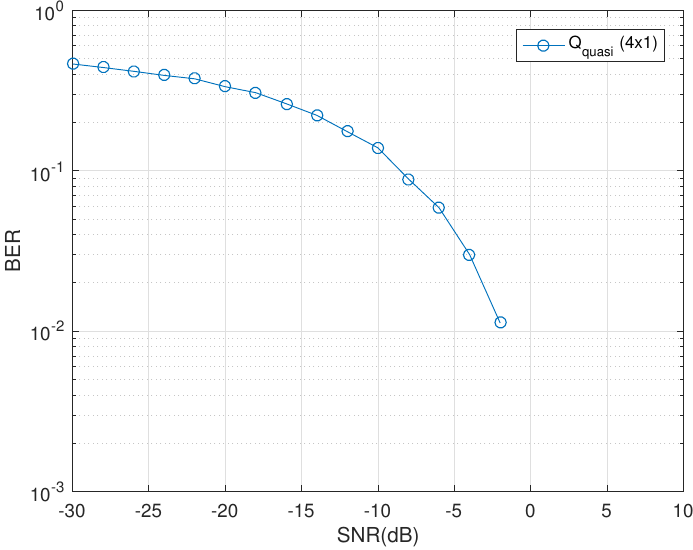
Figure 6. BER vs. SNR performance of Q quasi for one receive dual-polarized